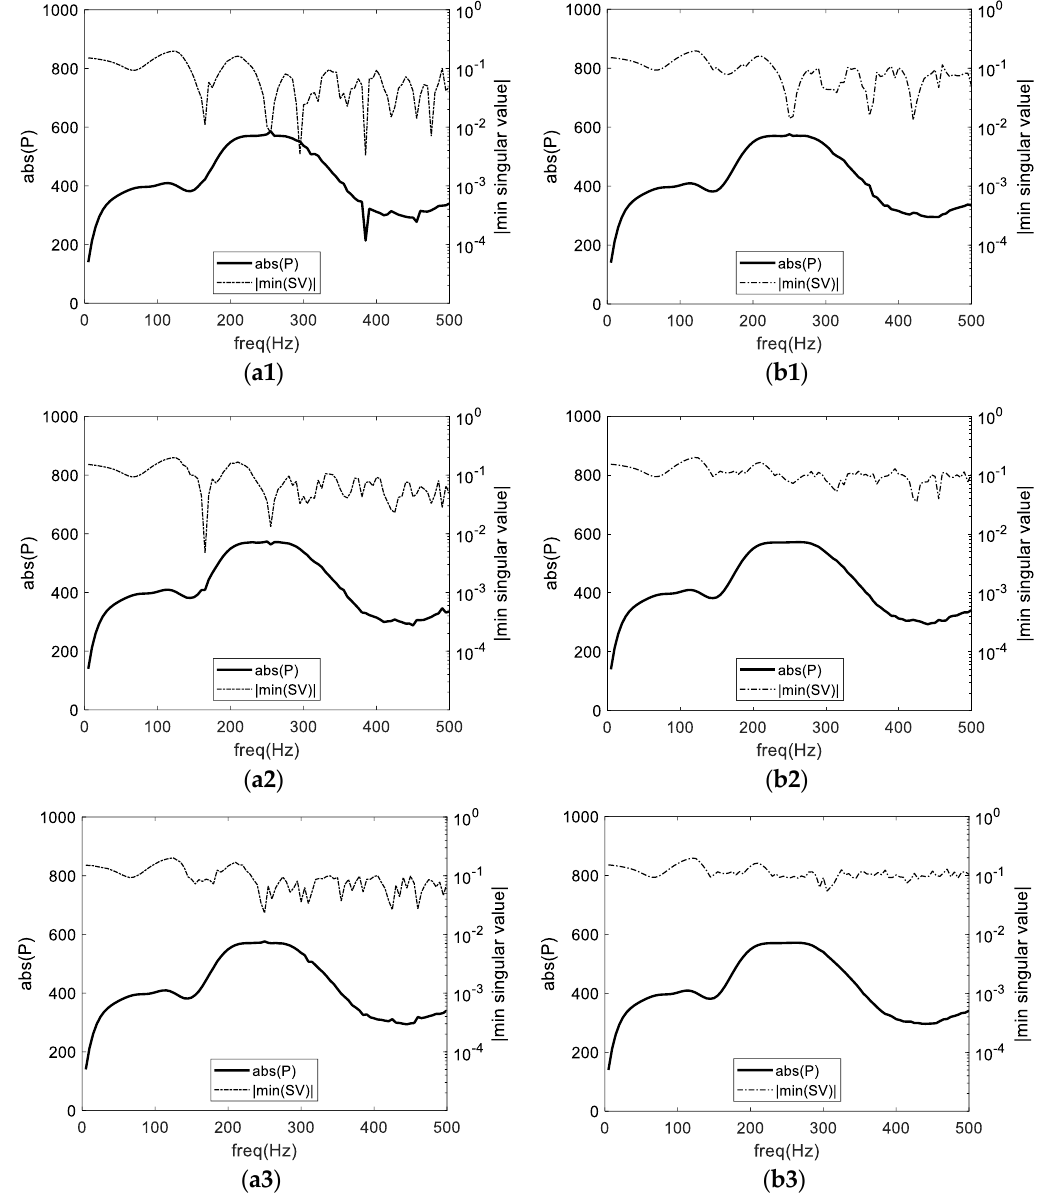
Figure 13. Response computed for the second test problem, considering either ( a1 – a3 ) fixed or ( b1 – b3 ) optimized CHIEF point positions, for one ( a1 , b1 ), two ( a2 , b2 ) or three ( a3 , b3 ) points. For the optimized case, this number of points is the maximum considered in the optimization process.